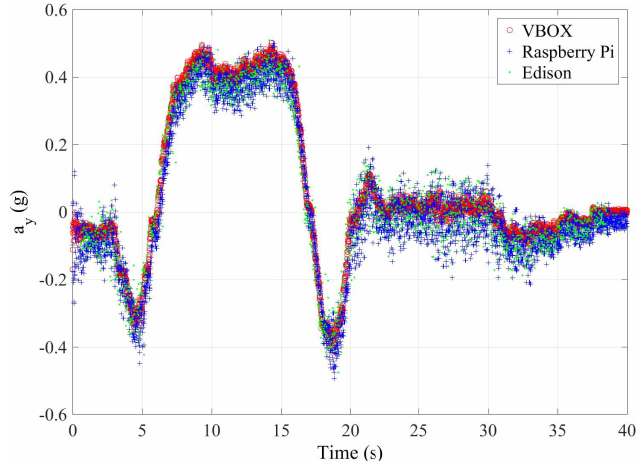
Figure 8. Test 1: Lateral acceleration obtained from the IMU of VBOX (red points), from the IMU of Raspberry pi (blue points) and from the IMU from Intel Edison (green